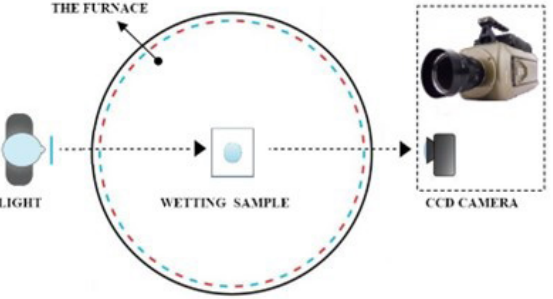
Figure 2. Schematic of photographic facilities using in wetting experiments, what inside the circle with dash line is actually invisible viewing from the